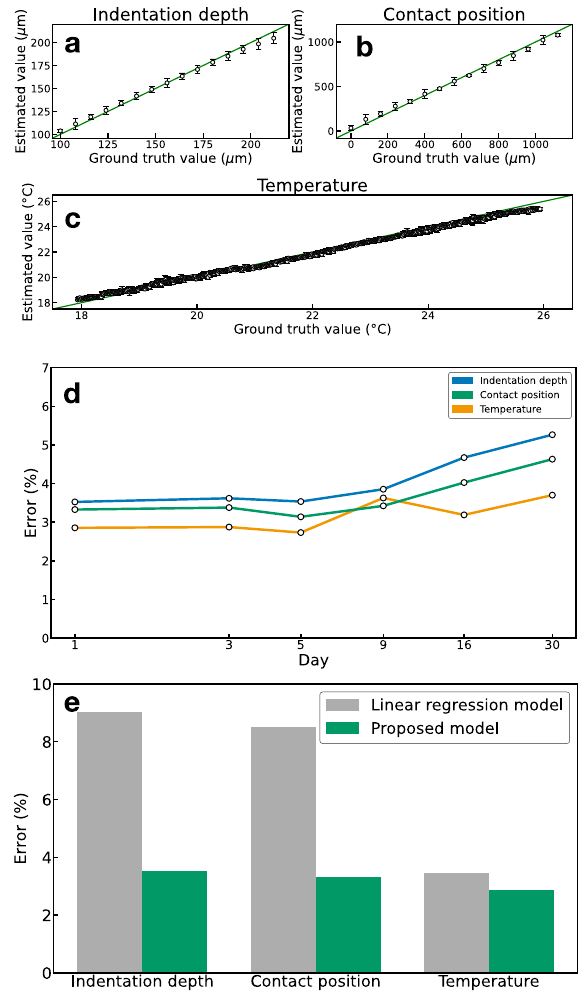
Figure 4. Sensing performance. With our sensing approach, we simultaneously estimated the indentation depth, contact position, and temperature of the silicone material. The estimated values of (a) the indentation depth, (b) contact position, and (c) temperature were compared with ground truth values. The error bars represent standard deviations. (d) Long-term stability of our sensing approach. The increase in the estimation errors was within 1.7 % for 30 days after the training. (e) Model comparison. The estimation errors of the proposed model shown in Fig. 2d are compared with a linear regression model, which does not contain hidden